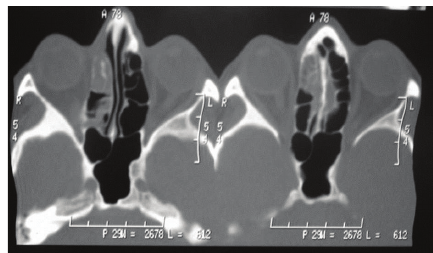
Figure 4: CT section of the region.